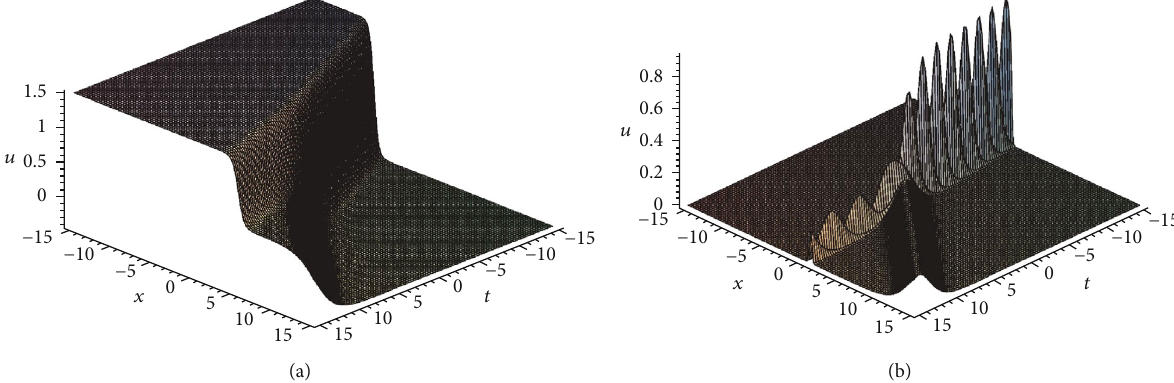
Figure 2: Plot (a) and (b) to the resonant soliton solution of u and v with k > 0 . (a) is a graph of u , which shows that two kink solitary waves collide and fuse into a resonant soliton solution at t = 0 . (b) is a graph of v , which shows that two bell solitary waves collide and fuse into a resonant soliton solution at t = 0 .